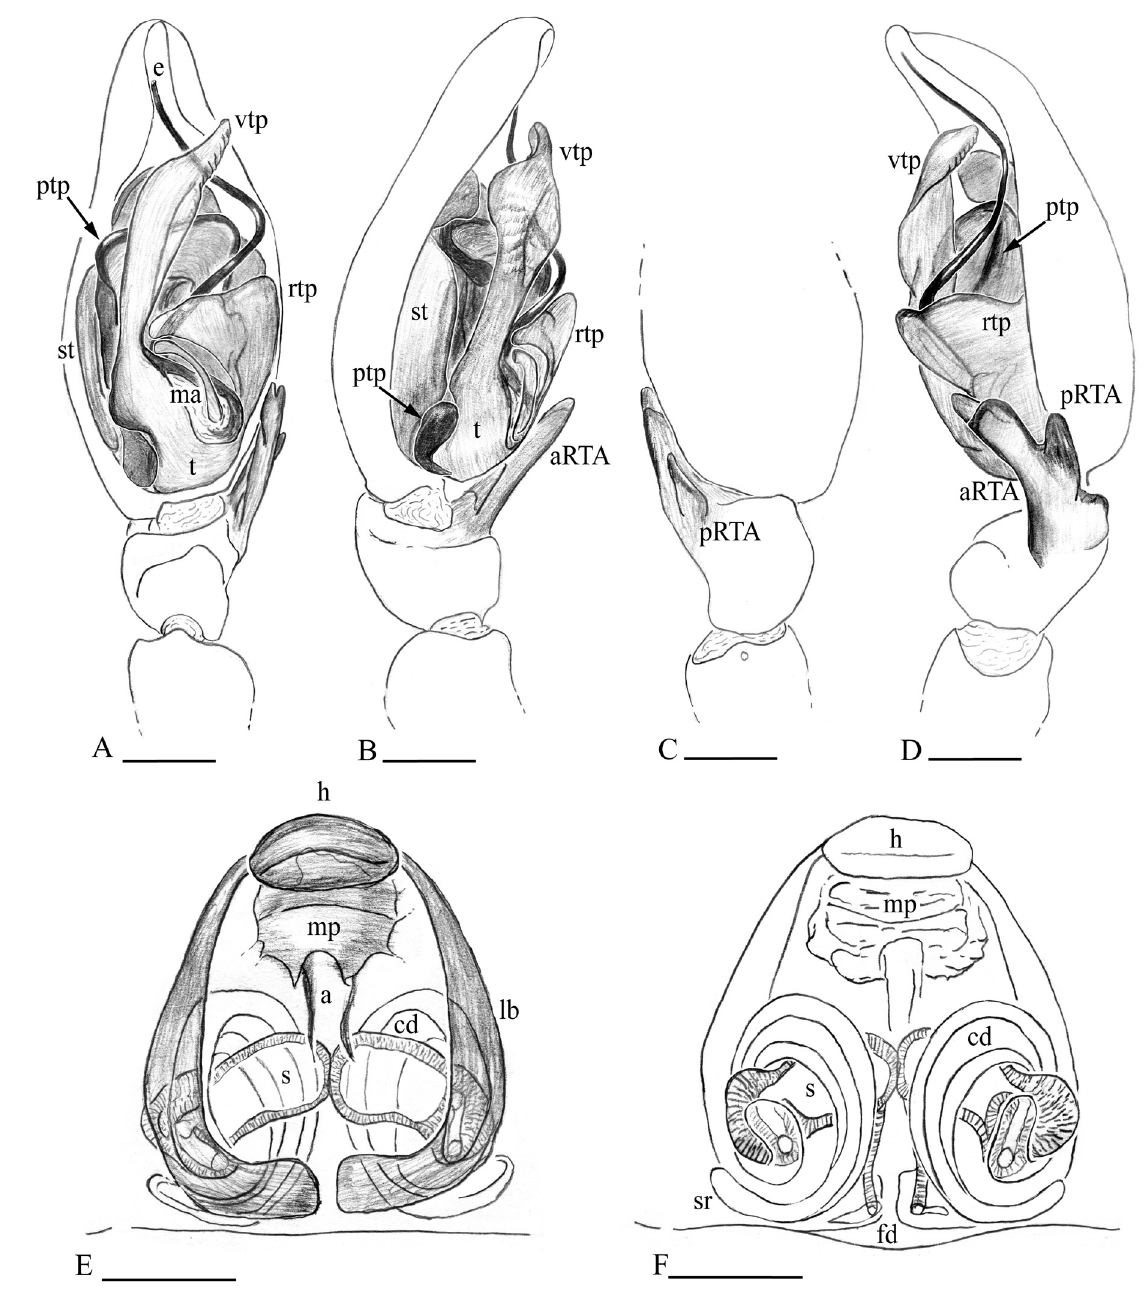
Fig. 8. Anyphaena adnani sp. nov. A–D . Paratype, ♂ (CNAN-T01545). E–F . Paratype, ♀ (CNAN-T01546). A . Pedipalp, ventral view. B . Pedipalp, prolateral view. C . Pedipalp, dorsal view. D . Pedipalp, retrolateral view. E . Epigynum, ventral view. F . Epigynum, dorsal view. Scale bars: A–D = 0.2 mm; E–F = 0.1